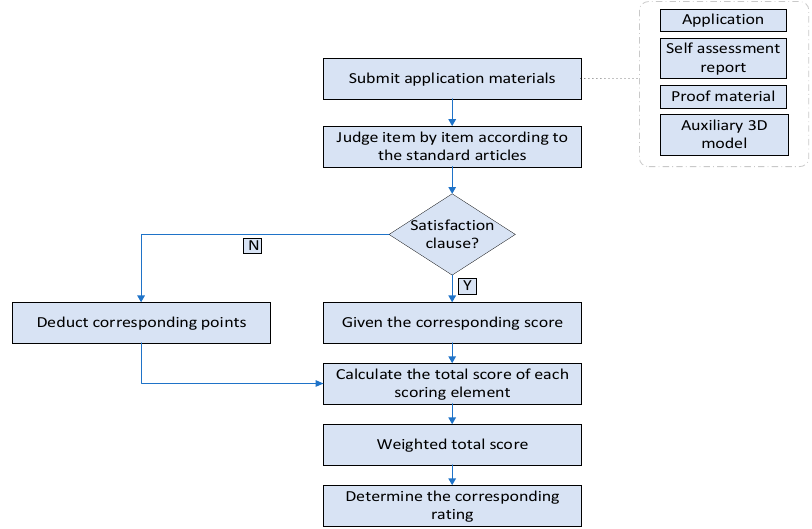
Figure 1. Scoring method for building interior decoration based on green evaluation standards.